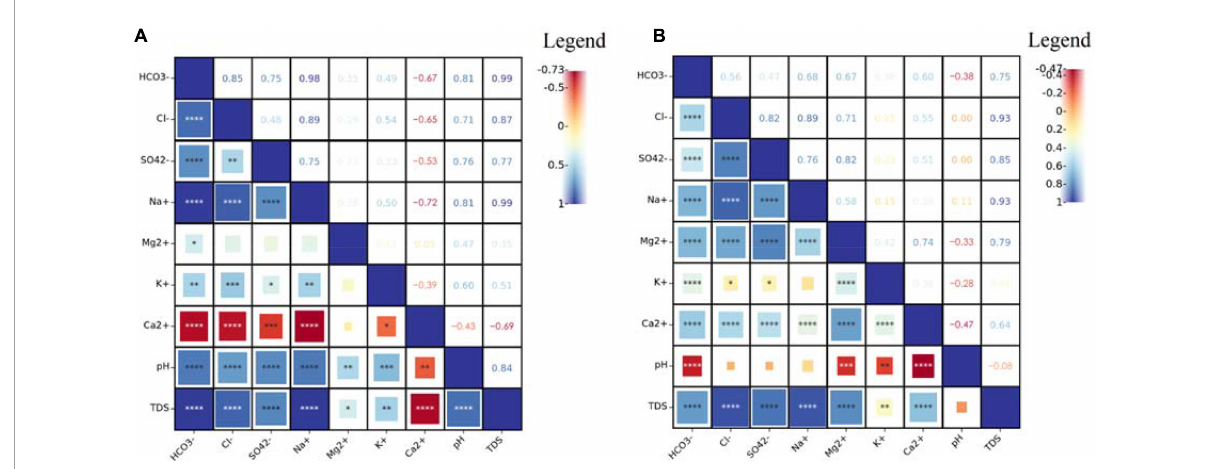
FIGURE5 Scatter plot of the relationship between main ions in groundwater and lake water.